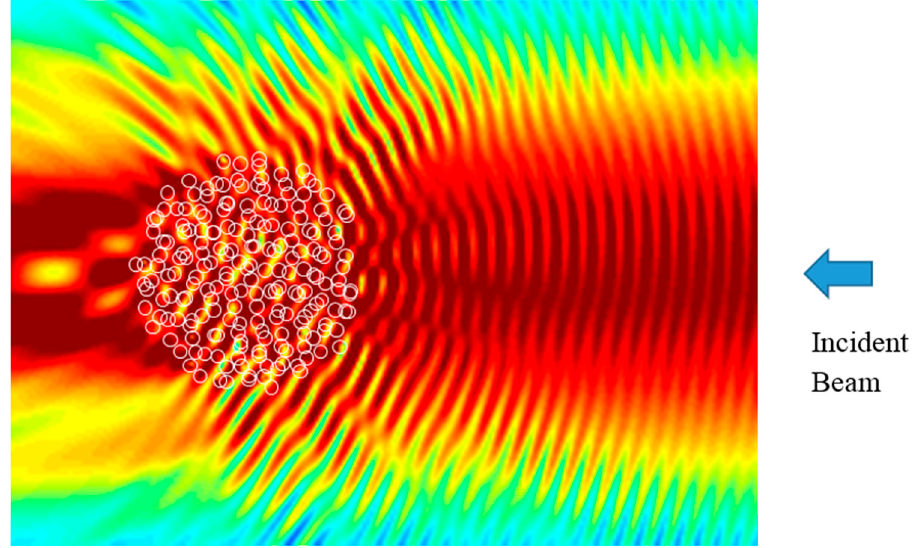
Figure 5. Scattering behavior of 500 arbitrarily arranged spheres. The color gradient shows the local intensity. Simulation result of Celes software [32] (Karlsruher Institut fürTechnologie, Karlsruhe, Germany). The incident beam originates from the right side.